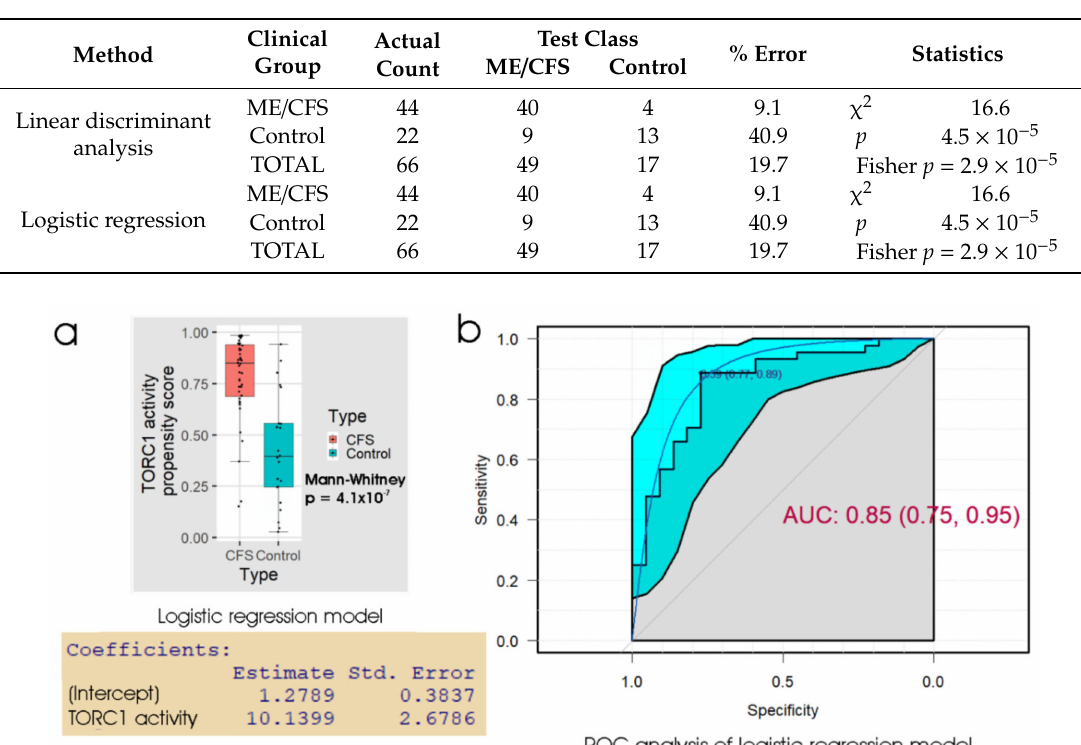
Table 3. “Confusion matrix” analysis of lymphoblast TORC1 activity.